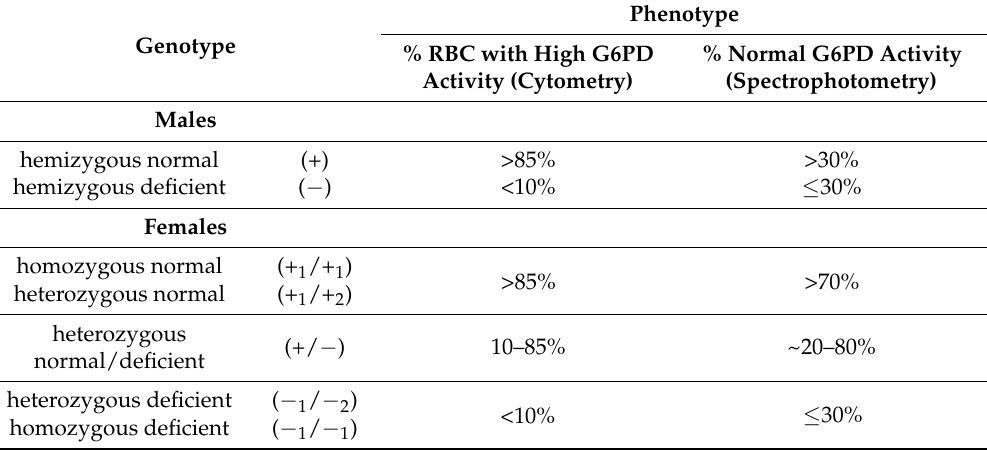
Table 1. Association between genotype and phenotype. Two methods of measuring phenotype are shown: (1) by cytochemical staining, where red blood cells (RBC) are arbitrarily assigned as having high glucose-6-phosphate dehydrogenase (G6PD) activity or low G6PD activity [5] and (2) by spectrophotometric G6PD enzyme activity measurement in whole blood. The activity is described in terms of percentage of a population’s normal value [39,40]. Phenotype Genotype % RBC with High G6PD % Normal G6PD Activity Activity (Cytometry)